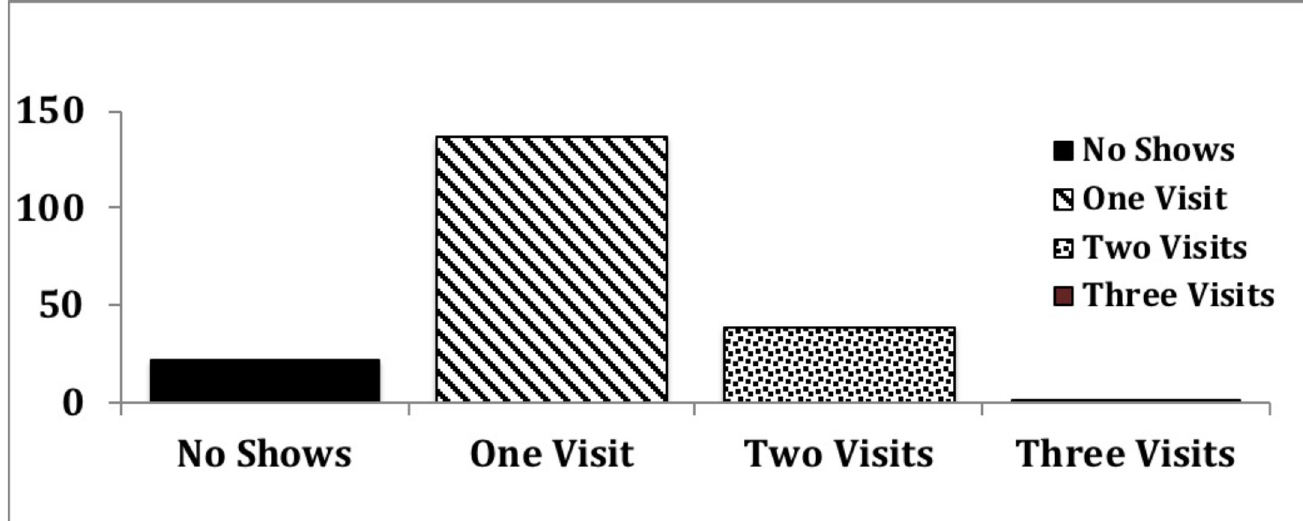
Fig 1. Dialysis modality choice by the number of CPE clinic visit. Fig 1 shows the number of CPE clinic patients elected to attend, when provided with an option to decide a follow up visit based on their comfort level for reaching dialysis choice. Each column is further subdivided into the patient choice for the different dialysis modalities with bars representing the proportion of patients reaching the given modality